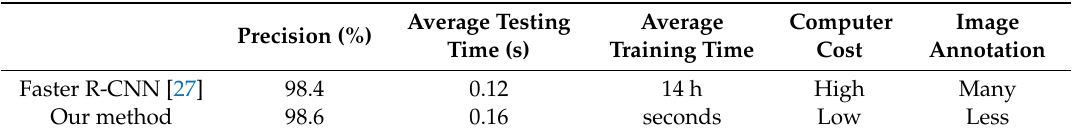
Table 5. Comparison with Faster-RCNN.